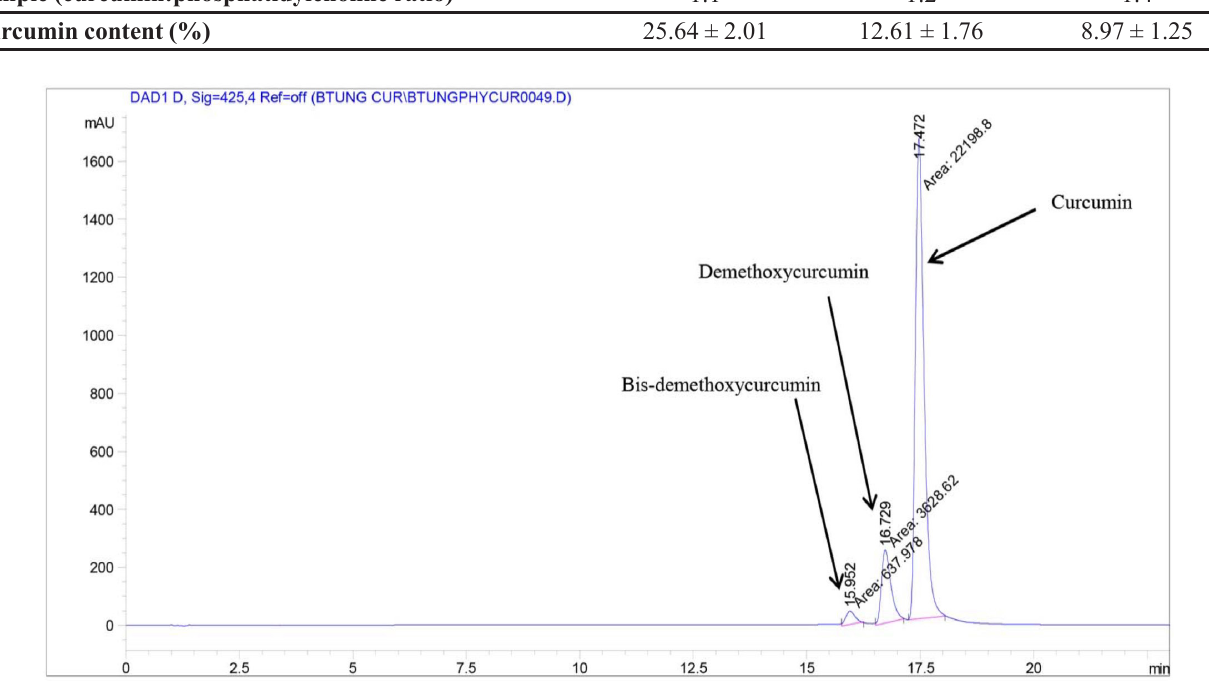
FIGURE 3 - Representative chromatograms HPLC chromatographical of Phytosome curcumin with curcumin: phosphatidylcholine ratio (mol:mol) is